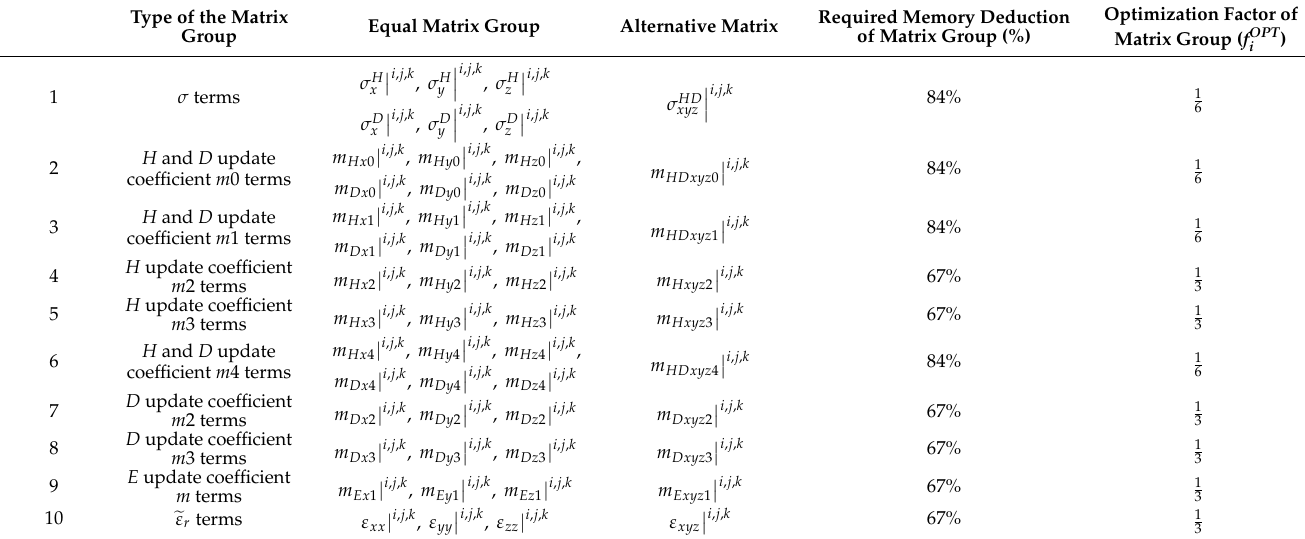
Table 2. Equal 3D matrix groups in the FDTD modelling can be replaced by only a single alternative 3D matrix in OFDTD, which reduces the required memory for the